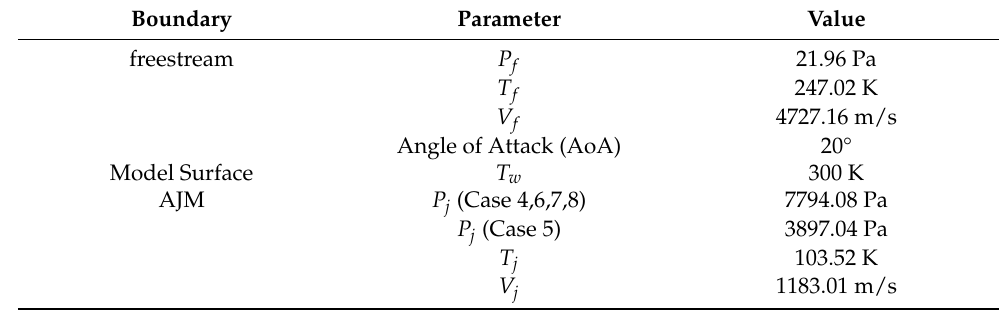
Table 3. List of Boundary Conditions.